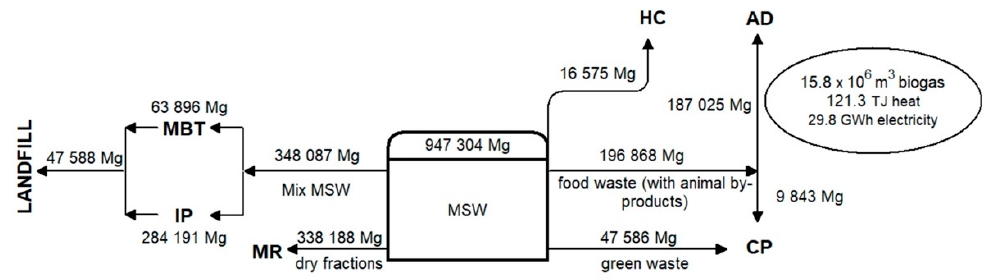
Figure 9. MFA for TS ‐ III, prediction for 2030.